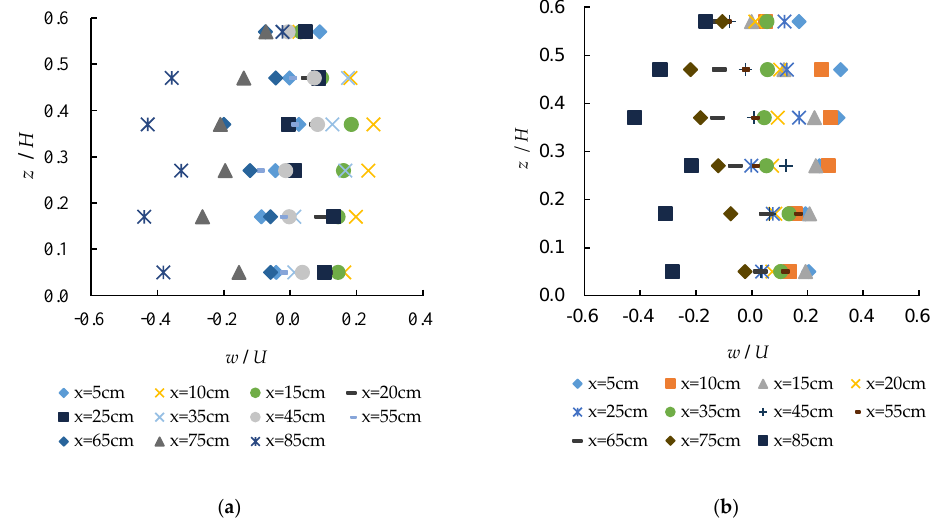
= 20.79 L / s; ( b ) Q = 30.04 L / s. 1 2